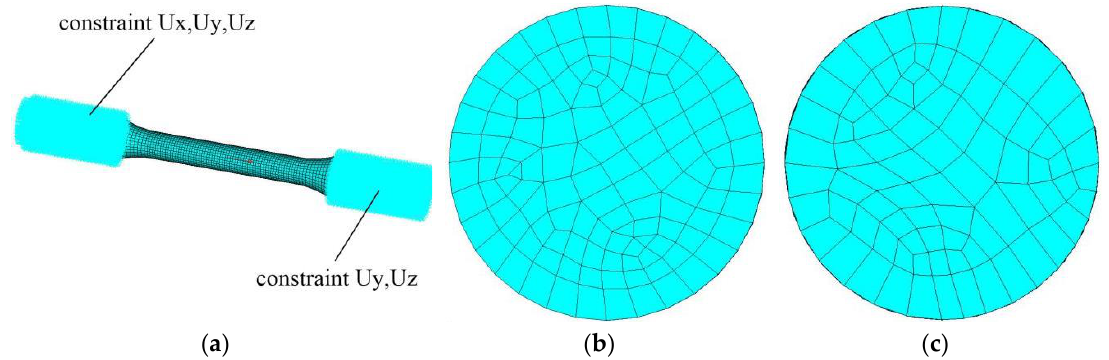
Figure 10. Finite element model: (a) boundary conditions of the model; (b) mesh generation of parallel